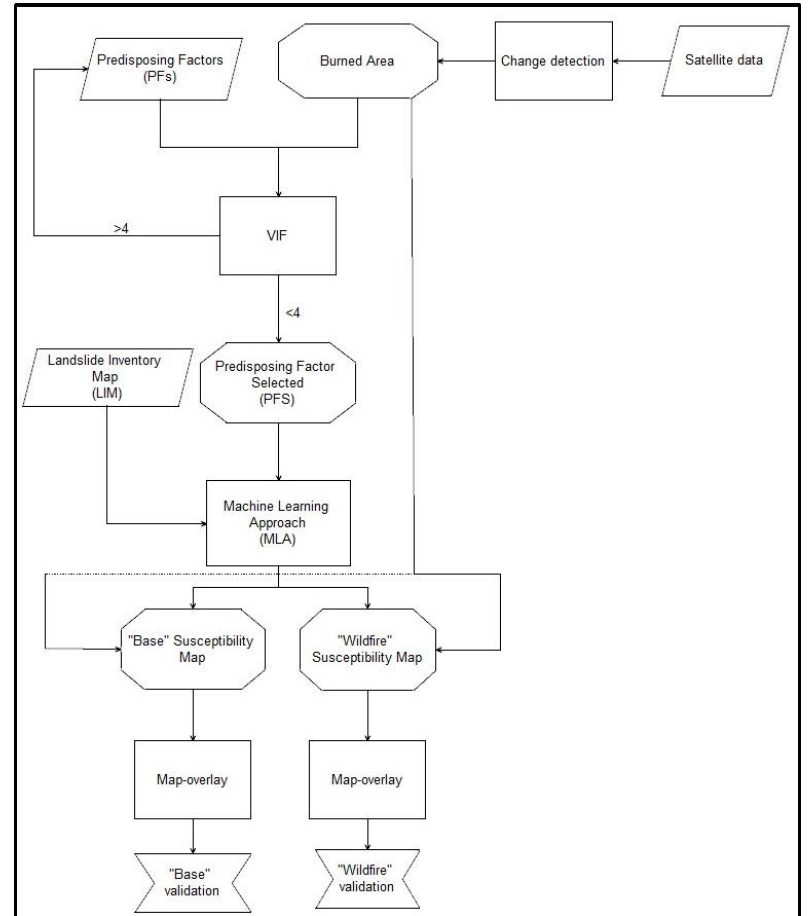
Figure 3. Flow chart of the implemented approach.